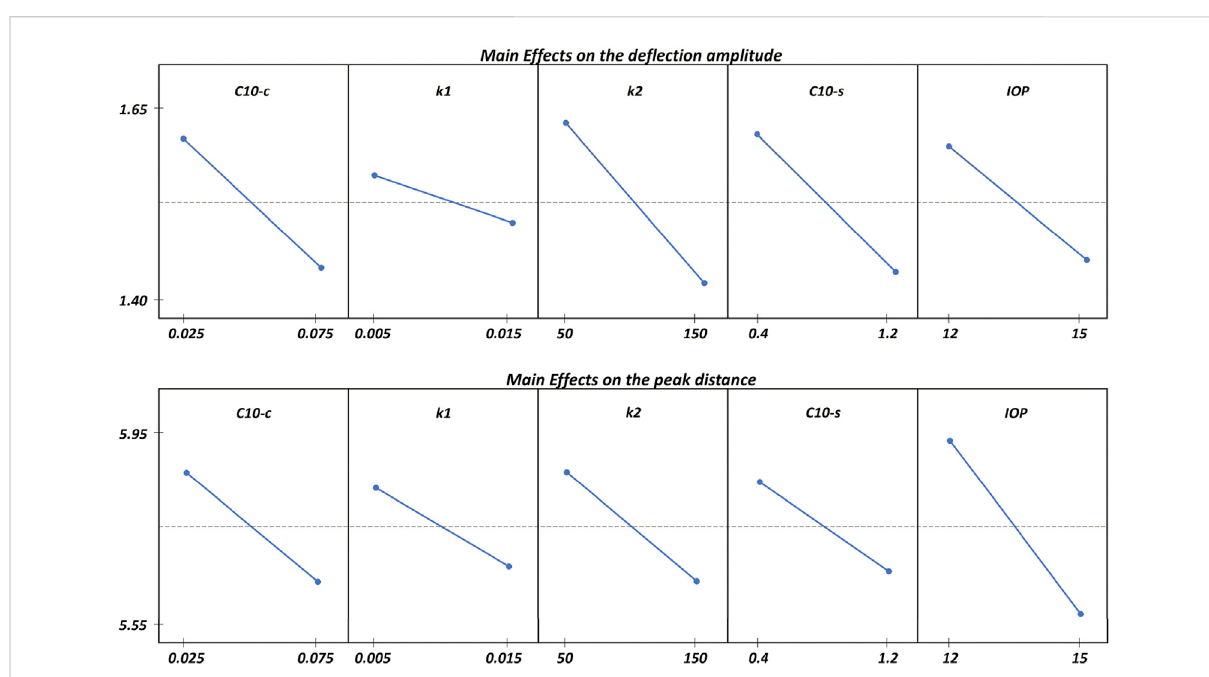
FIGURE 9 Main Effects plot oftheanalysed factors on thede fl ection amplitude and on thepeak distance. All theparametersshow an inversein fl uence on the results.